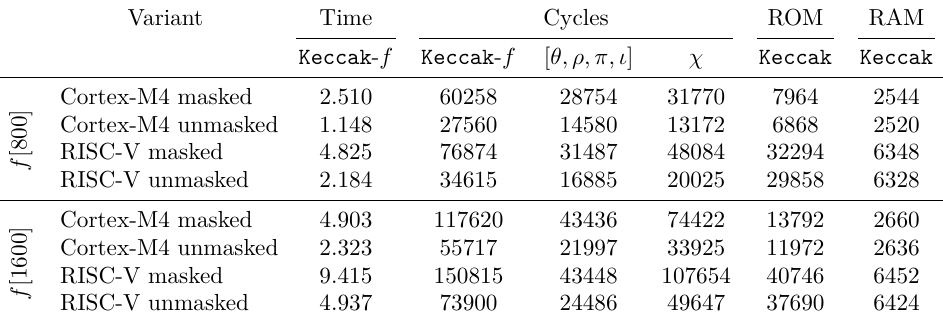
Table 4: Implementation results of the Keccak hash function and Keccak - f permutation. The first four rows detail Keccak - f [800] while the last four rows detail Keccak - f [1600]. Time is given in milliseconds, and ROM and RAM are given in